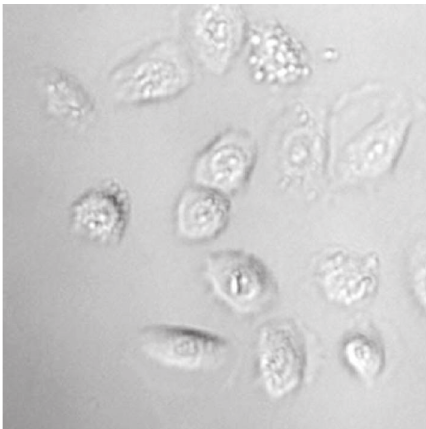
Figure 1: Vaginal epithelial cells cultured at KSFM in polystyrene culture flasks. Photograph taken at × 400 with phase contract mi-